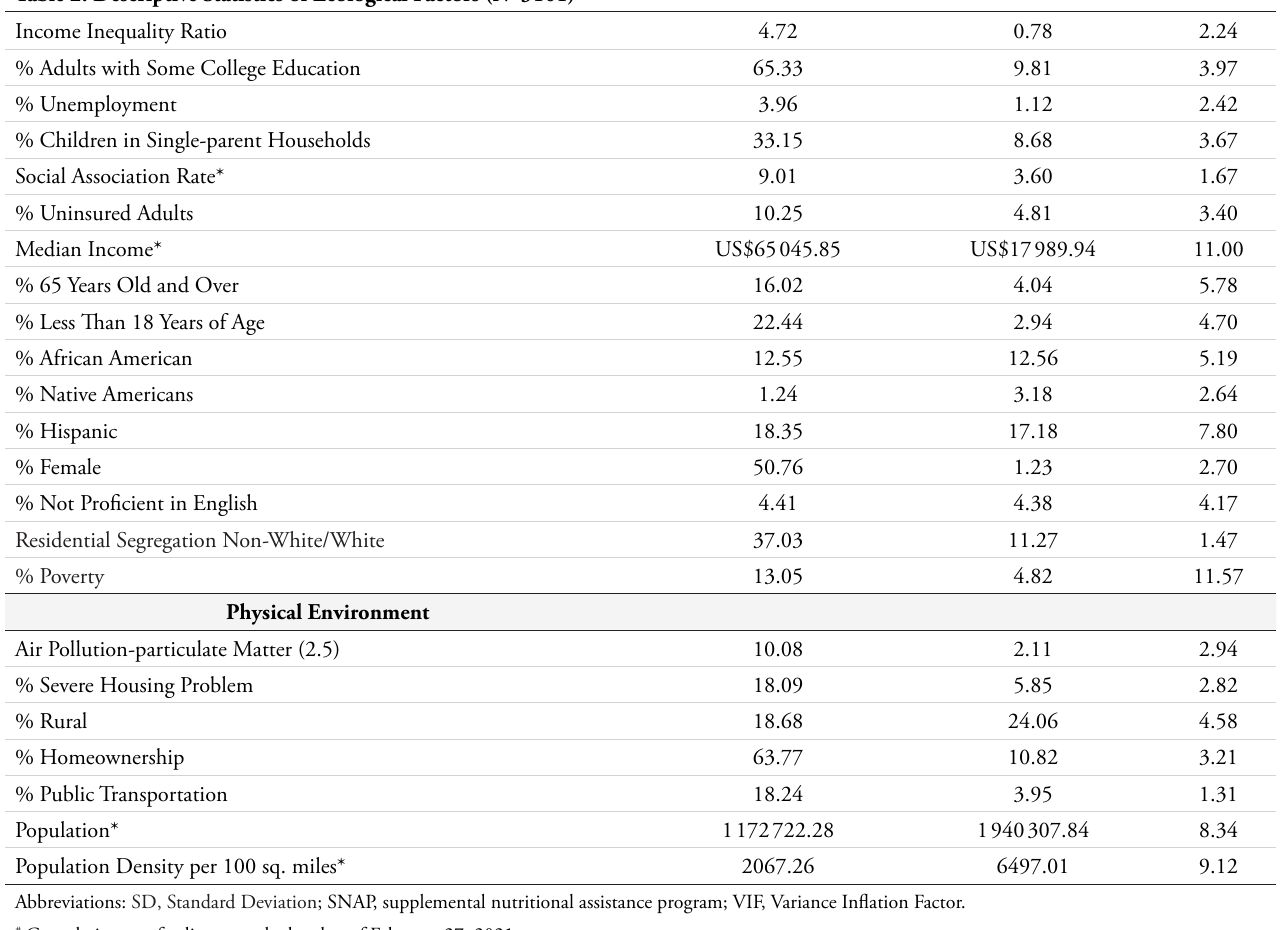
Table 2: Descriptive Statistics of Ecological Factors (N=3101)